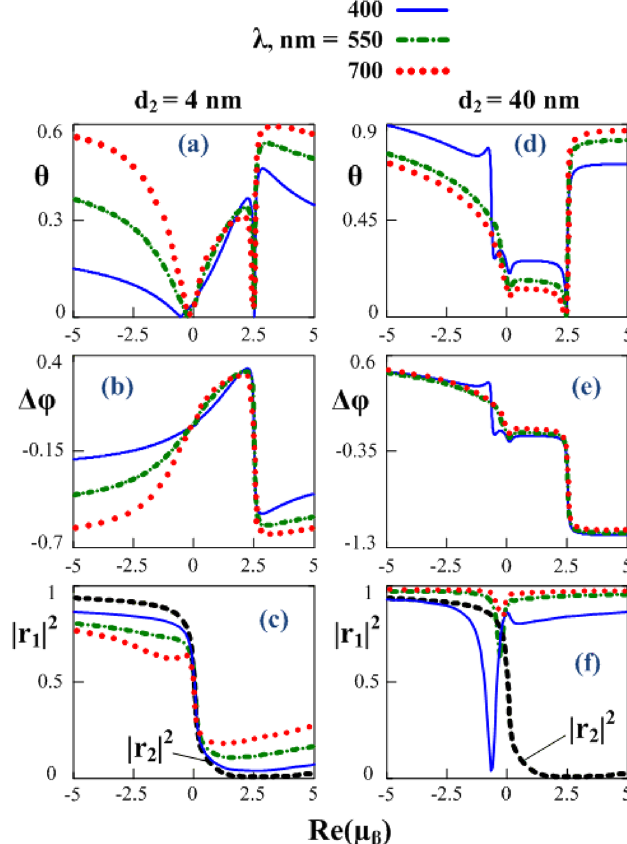
Fig. 12. Dependences of angle u (a, d), PSD of re fl ected waves (b, e) and corresponding energy re fl ection coef fi cients (c, f) on parameter m 0 b for various wavelengths of the incident wave with TE polarization. The values of parameters are: d 2 = 4nm (a – c), 40 nm (d – f), for all the graphs c = p /6, d 1,3,4 =0, m 00 b ¼ 0 : 1 , e b = 2+0.1 i , and the main layer material is silver. Parameter used as the abscissa axis for all the